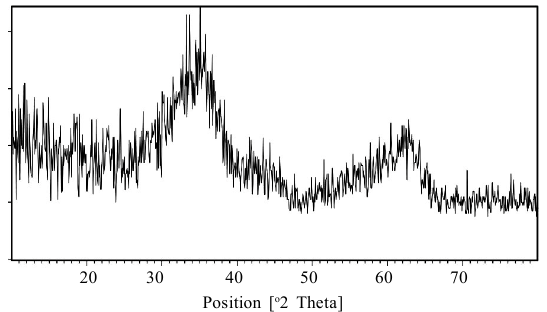
Fig. 1. XRD pattern of Fe